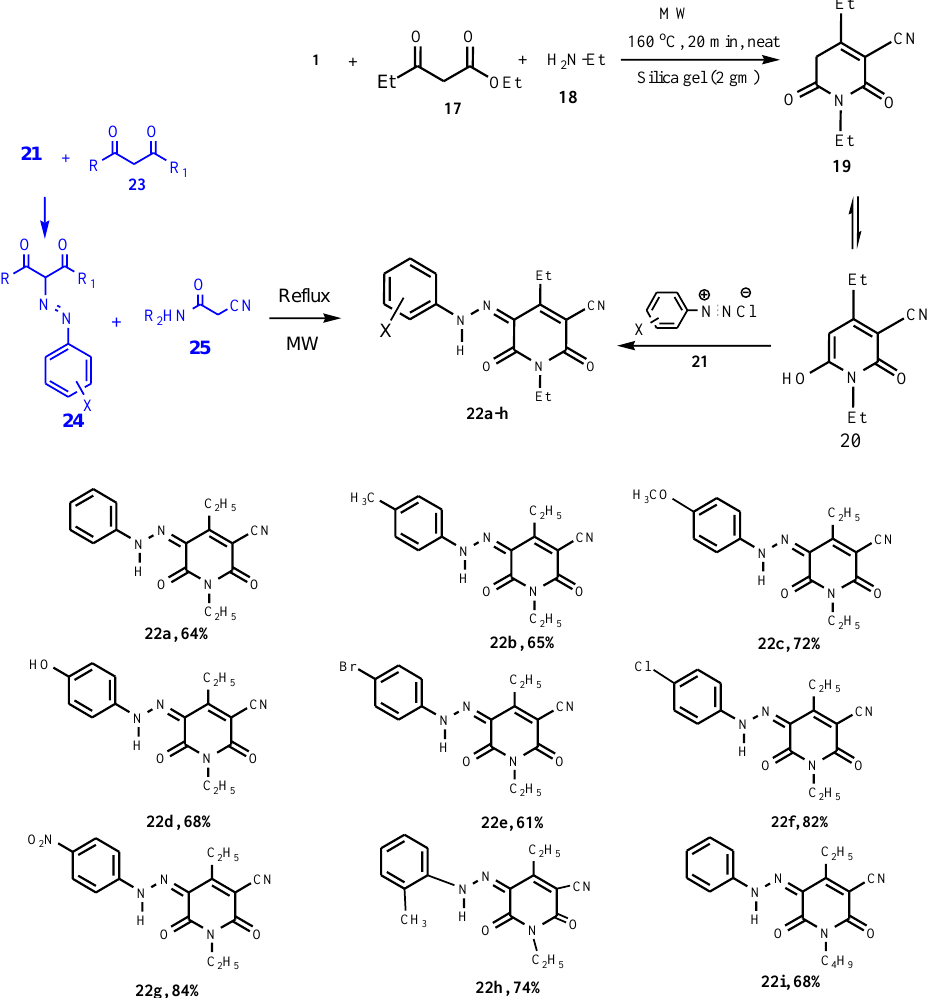
Figure 5. ORTEP of dye 22g.